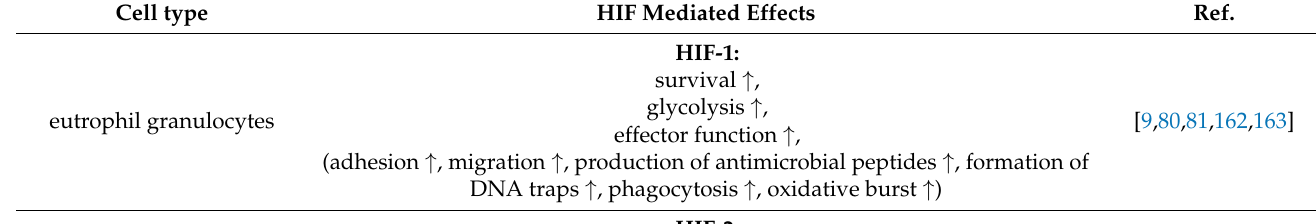
Table 1. HIF-mediated effects in myeloid